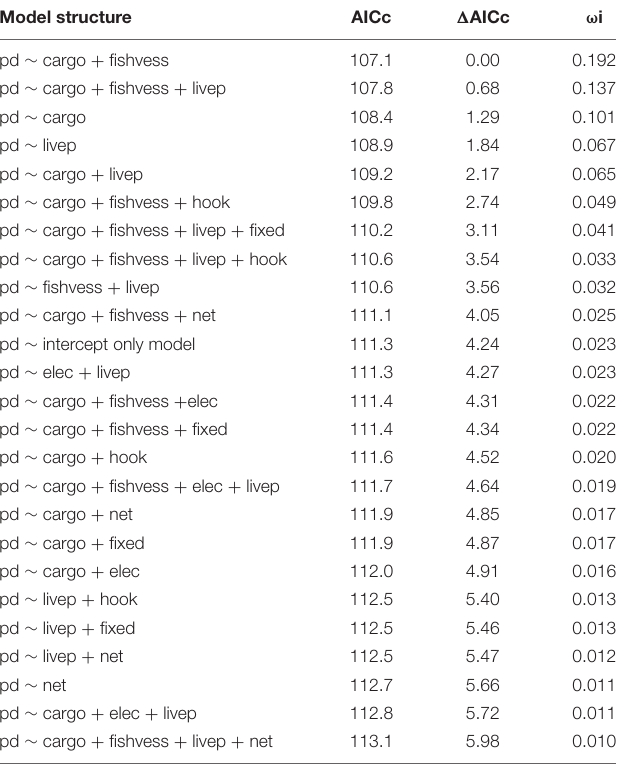
TABLE 1 | Beta-binomial model selection showing (cid:49) 6 set for Yangtze-wide analysis, reporting Akaike Information Criterion corrected for small sample sizes (AICc), AICc scores ( (cid:49) AICc) and Akaike’s weight ( ω i).